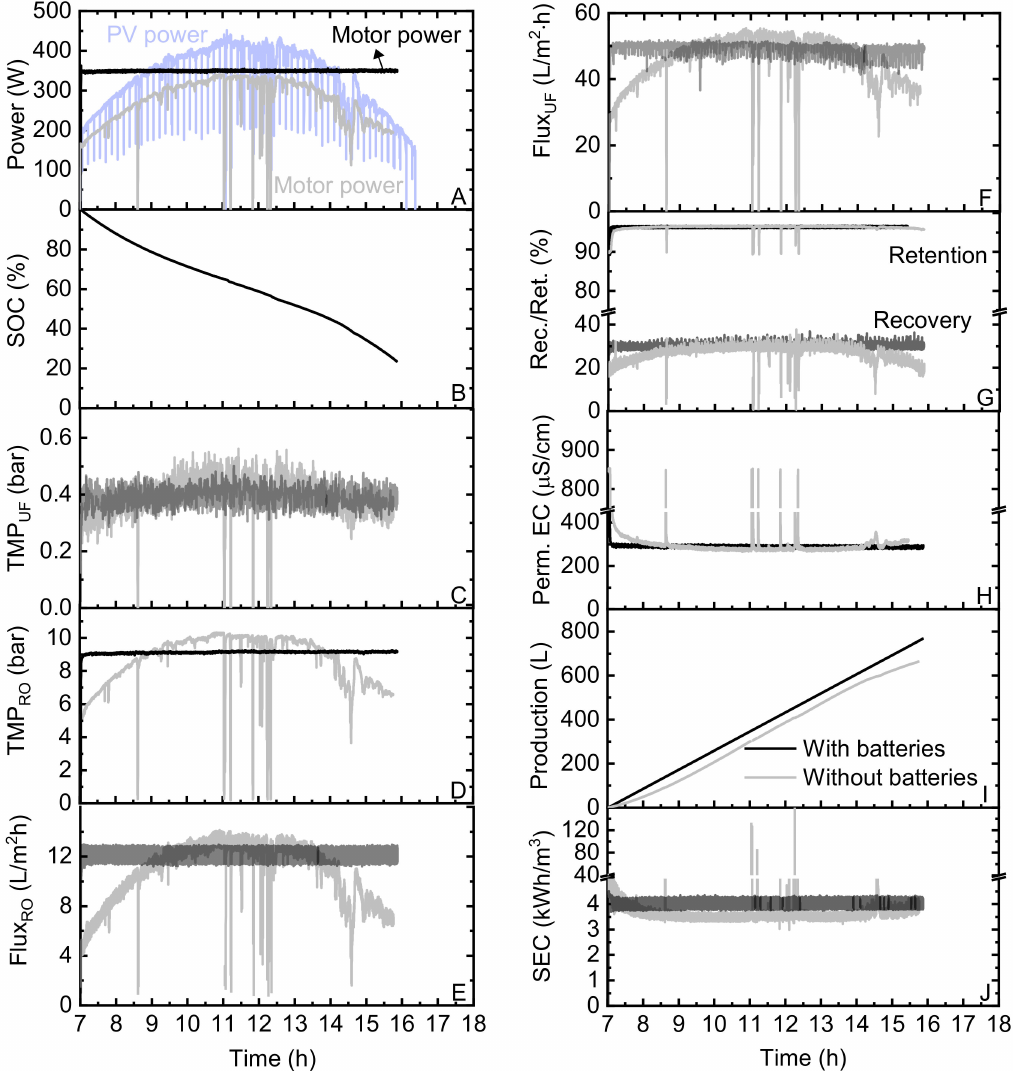
Figure 3. Performance of the PV-membrane system shown, firstly, with fully charged battery storage (100% initial state- of-charge (SOC), black curves) and, secondly, the reference system without energy storage (grey curves) on the “partly cloudy day”: ( A ) power, ( B ) SOC, ( C ) transmembrane pressure of UF membrane (TMP UF ), ( D ) transmembrane pressure of RO membrane (TMP RO ) ( E ) flux of RO membrane (flux RO ), ( F ) flux of UF membrane (flux UF ), ( G ) retention/recovery, ( H ) permeate electrical conductivity (EC), ( I ) production and ( J ) specific energy consumption